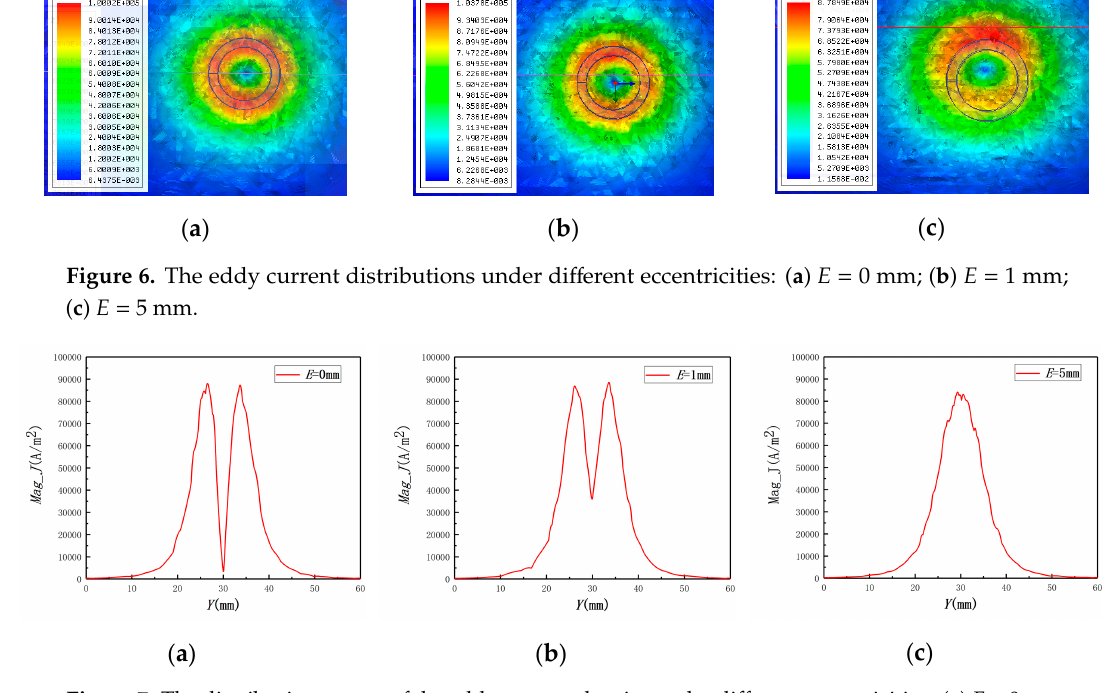
Figure 7. The distribution curves of the eddy current density under different eccentricities: ( a ) E = 0 mm; ( b ) E = 1 mm; ( c ) E = 5 mm.